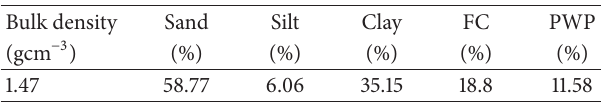
Table 1: Physical characterization of Ultisol used for growing sugarcane by Beb´e et al., 2009